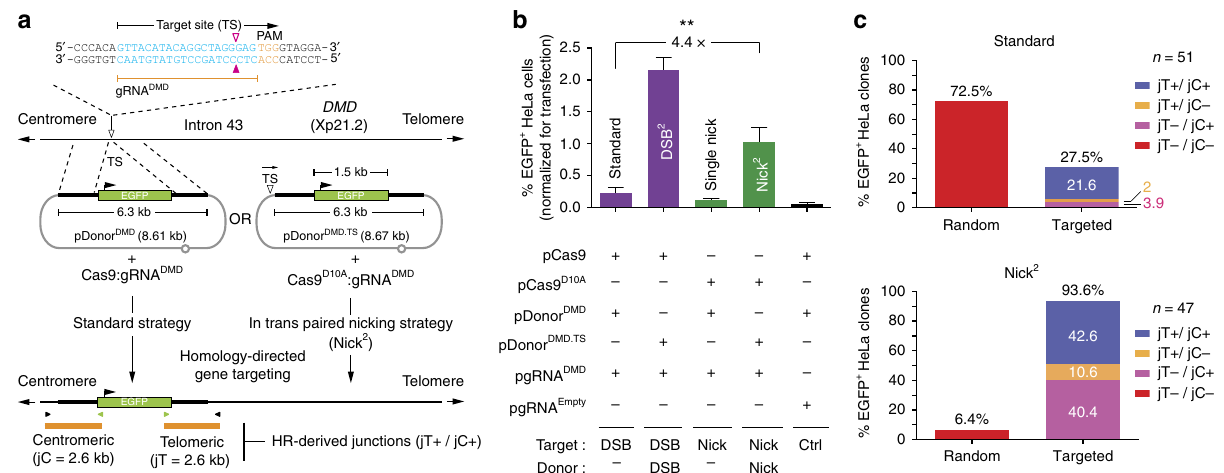
Fig. 1 Homology-directed DMD -targeting using standard and in trans paired nicking strategies. a Schematics of standard and in trans paired nicking (Nick 2 ) procedures. The former involve DSB formation only at the target sequence; the latter comprise SSB formation at target plus donor sequences. pDonor DMD and pDonor DMD.TS have their transgenes fl anked by sequences identical to those framing the gRNA DMD target site (TS). Open and solid magenta arrowheads , position of the phosphodiester bond cleavage induced by Cas9 ’ s RuvC and HNH nuclease domains, respectively. Solid arrowhead , position of the SSB induced by Cas9 D10A . The modi fi ed pDonor DMD.TS differs from pDonor DMD in that it has the gRNA DMD TS next to its targeting module. The transgene is formed by human PGK1 promoter, EGFP ORF, and bovine GH1 polyadenylation signal sequences. Cas9:gRNA DMD and Cas9 D10A :gRNA DMD are cleaving and nicking RGN complexes, respectively. PAM protospacer adjacent motif. An integrant generated by HR events at both ends of the targeting module is depicted. The amplicons speci fi c for telomere-sided and centromere-sided transgenic- DMD junctions (jT and jC, respectively), are equally shown. Horizontal arrowheads , primers. b Quanti fi cation of stable transfection levels by fl ow cytometry. Flow cytometry of long-term HeLa cell cultures initially exposed to the indicated plasmids. The bars correspond to mean ± s.d. of three independent biological replicates done on different days. ** P = 0.006 (two-tailed t -test). c Cumulative molecular characterization of integrants generated by the conventional vs. the in trans paired nicking strategies. The frequencies of clones with random insertions (jT − /jC − ), HR-derived telomeric junctions (jT+/jC − ), HR-derived centromeric junctions (jT − /jC+) and HR-derived telomeric and centromeric junctions (jT+/jC+) are plotted. The corresponding PCR screening data are presented